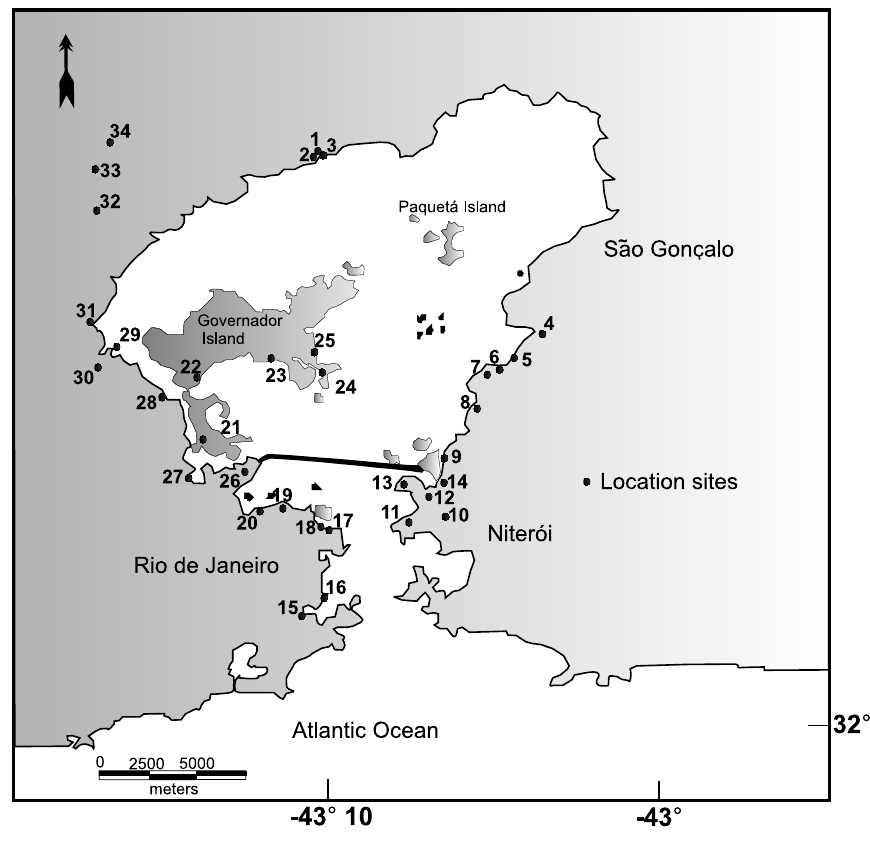
Fig. 1 – Location map of study